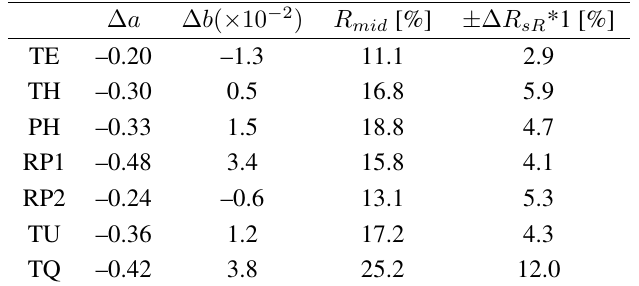
, ∆ R , ∆ a and ∆ b for seven soil sR sR